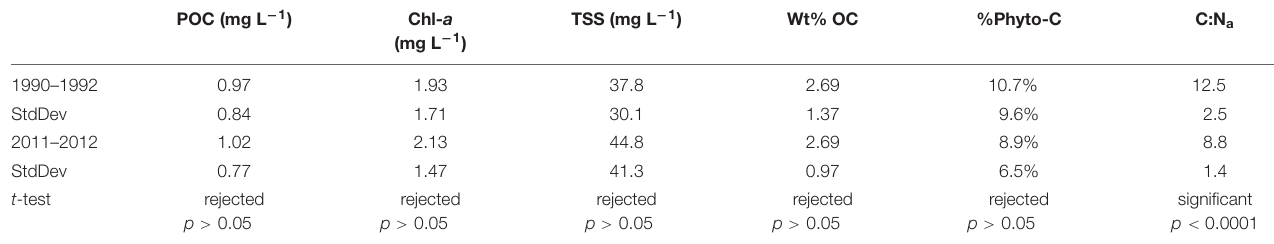
TABLE 2 | Select averages compared between two studies ∼ 20 years apart.